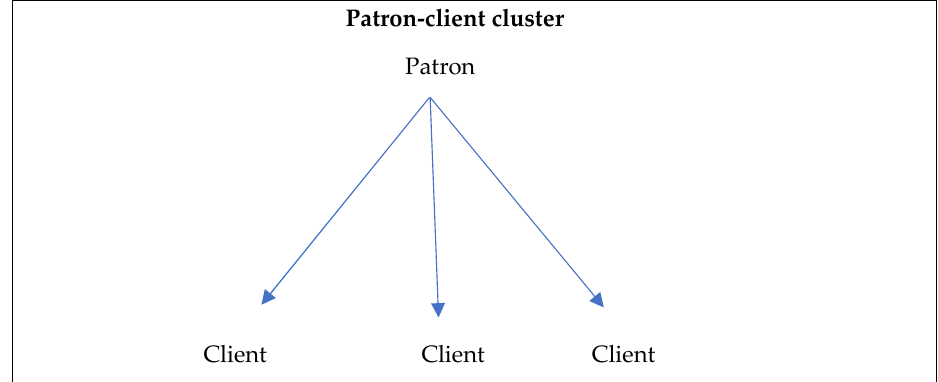
Figure 3. Patron-client cluster.